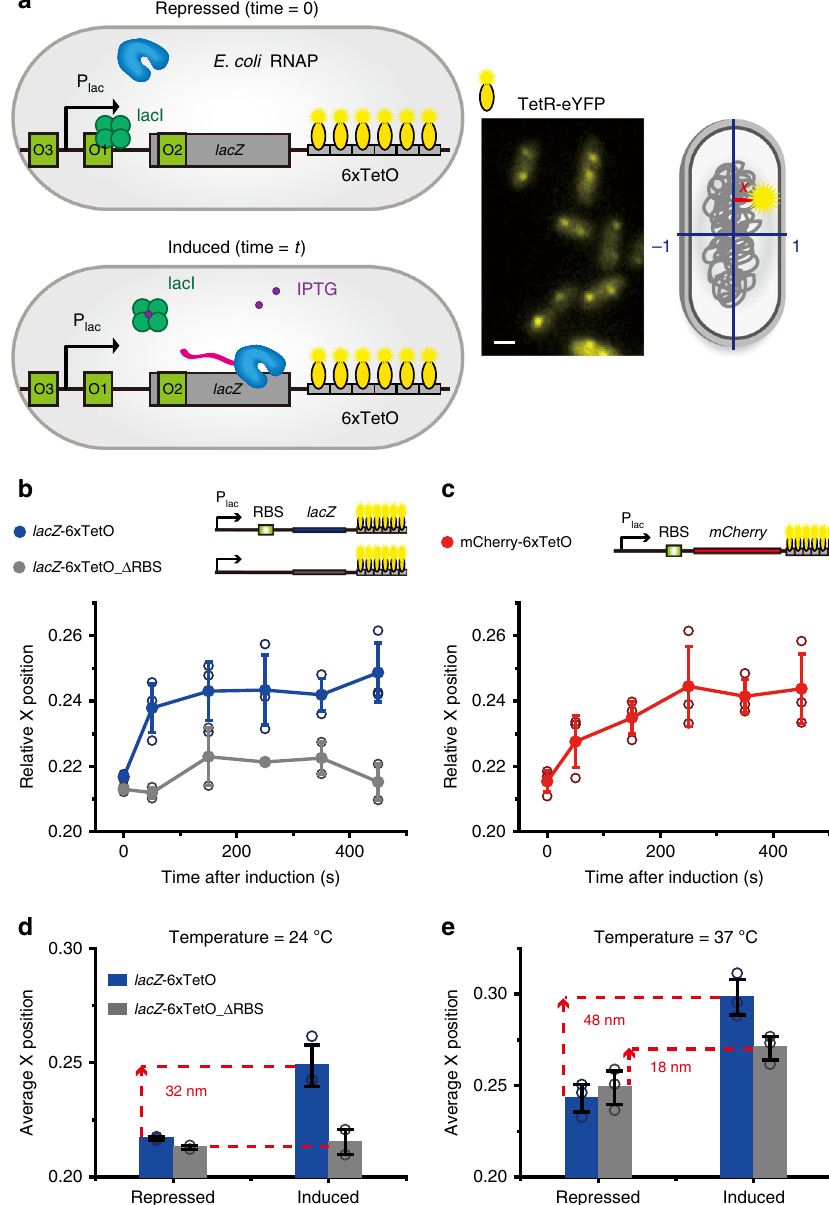
Fig. 3 Direct observation of the movement of a non-membrane protein gene locus by transcription of E. coli RNAP. a A schematic of the gene system used to detect location of the lacZ gene locus transcribed by E. coli RNAP (left panel). Six repeats of TetO (6xTetO) were inserted downstream of the lacZ gene or mCherry gene transcribed by E. coli RNAP. TetR-eYFPs bound to the TetO array were detected as a fl uorescent spot (middle panel). The localization error was 30 nm. Scale bar, 1 μ m. b Quantitative analysis of the movement of the lacZ gene locus. The lacZ gene locus moved to the nucleoid periphery after IPTG induction ( lacZ -6xTetO strain, blue squares) (>1500 spots). Movement of the lacZ gene locus following the RBS deletion ( lacZ -6xTetO_ Δ RBS strain, gray circles) was not observed (>800 spots). Data represent mean ± s.d. obtained from three independent experiments. Each point represents independent measurement. c Quantitative analysis of mCherry gene locus movement. Movement of the mCherry gene to the nucleoid periphery was observed after IPTG induction ( mCherry -6xTetO, red squares) (>940 spots). Data represent mean ± s.d. obtained from three independent experiments. Each point represents independent measurement. d , e Comparison of gene locus movement with and without the RBS at 24°C ( d ) and 37°C ( e ). Average relative x-positions of gene loci were obtained without IPTG (repressed) and 5 min after adding IPTG (induced). Blue bar, lacZ -6xTetO, and gray bar, lacZ -6xTetO_ Δ RBS. Bar and error bars represent mean ± s.d. from three independent experiments. Each point represents independent transcription system allows us to control the transcriptional signi fi cantly increased to 81 ± 14 nm at 24°C (Fig. 5b – d) relative activity through T7 RNAP concentration variation. Thus, we used to the 32 ± 9 nm distance driven by E. coli RNAP, as shown in T7 RNAP transcription system in this study. High transcription Fig. 3d. In addition, the outward movement of the lacZ gene locus levels were achieved by using high concentrations of T7 RNAP, in the axial direction (78 ± 32 nm) was also observed in the and the gene location was detected by 12xTetO (T7p_ lacZ - T7p_ lacZ -12xTetO strain (Supplementary Fig. 11), which was not 12xTetO). Indeed, the distance moved by the lacZ gene locus was observed in other experimental conditions that expressed less